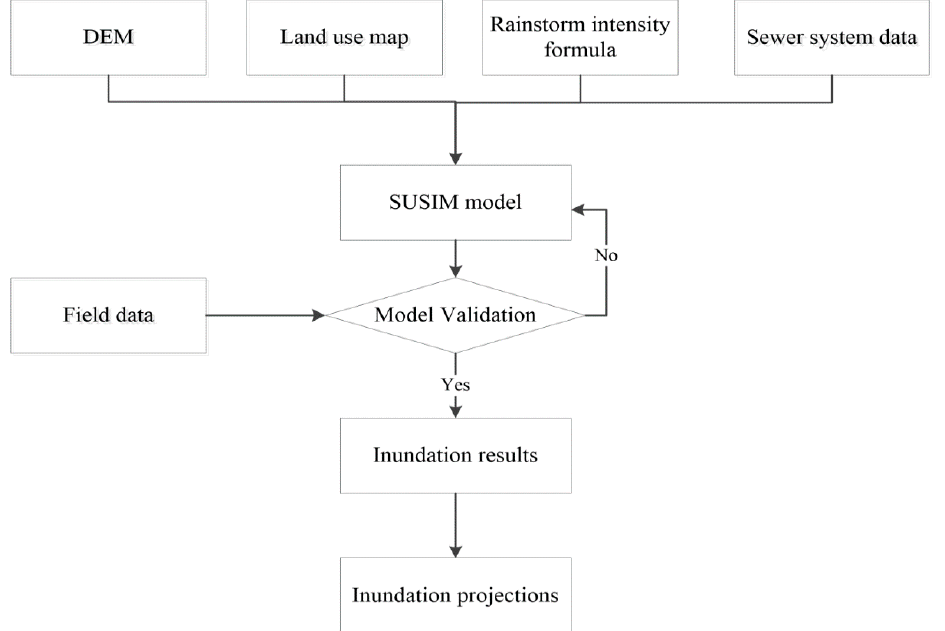
Figure 6. Flowchart of the simplified urban storm inundation model (SUSIM) model.